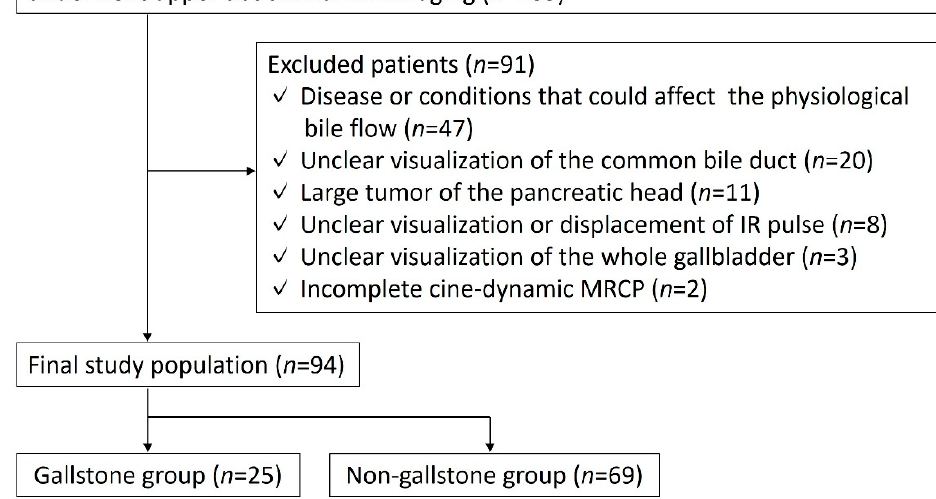
Figure 1. Flow chart of the included and excluded patients.